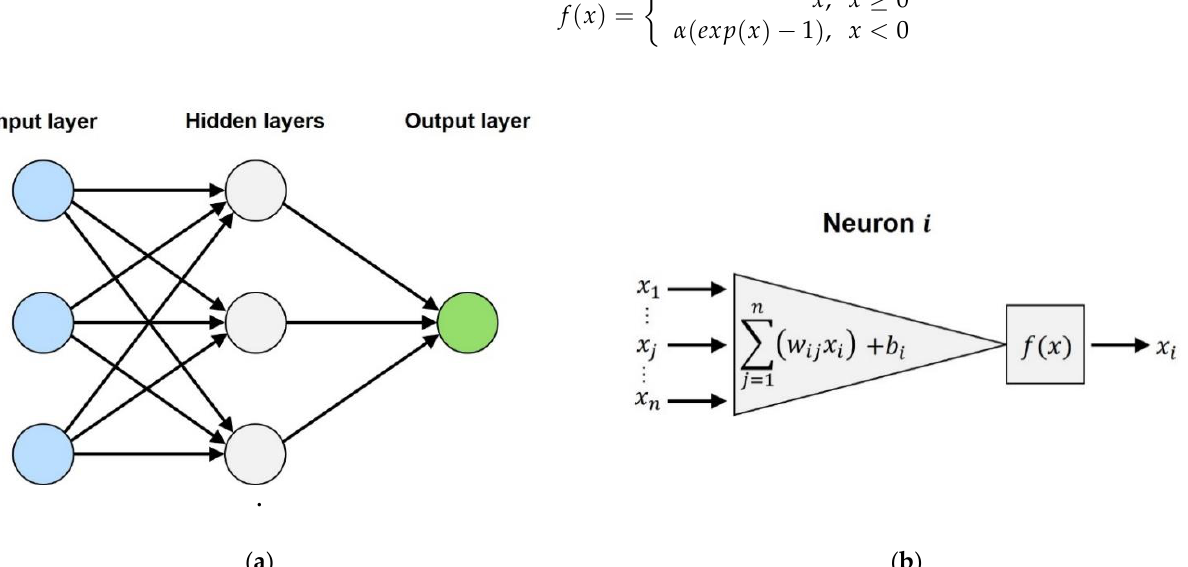
Figure 1. ( a ) structure of feedforward neural net featuring a single hidden layer; ( b ) calculation of the output of a neuron and transfer function.